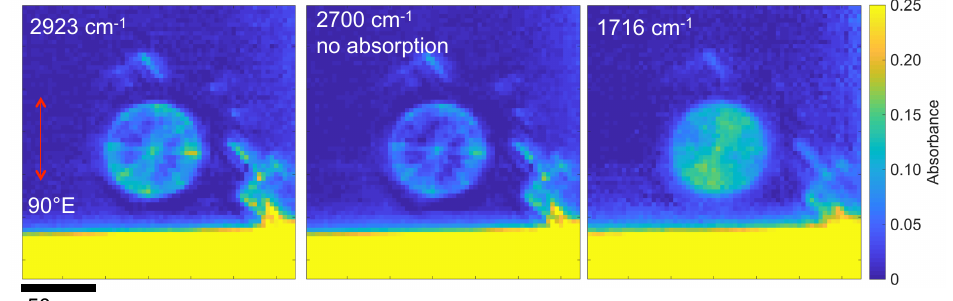
Figure 4. Absorbance images taken using a thermal IR source and the FPA detector at different wavenumbers for the vertically polarised E-field. Note the same scale of absorbance used for comparison. An optical image of the sample is shown in Figure 3a.